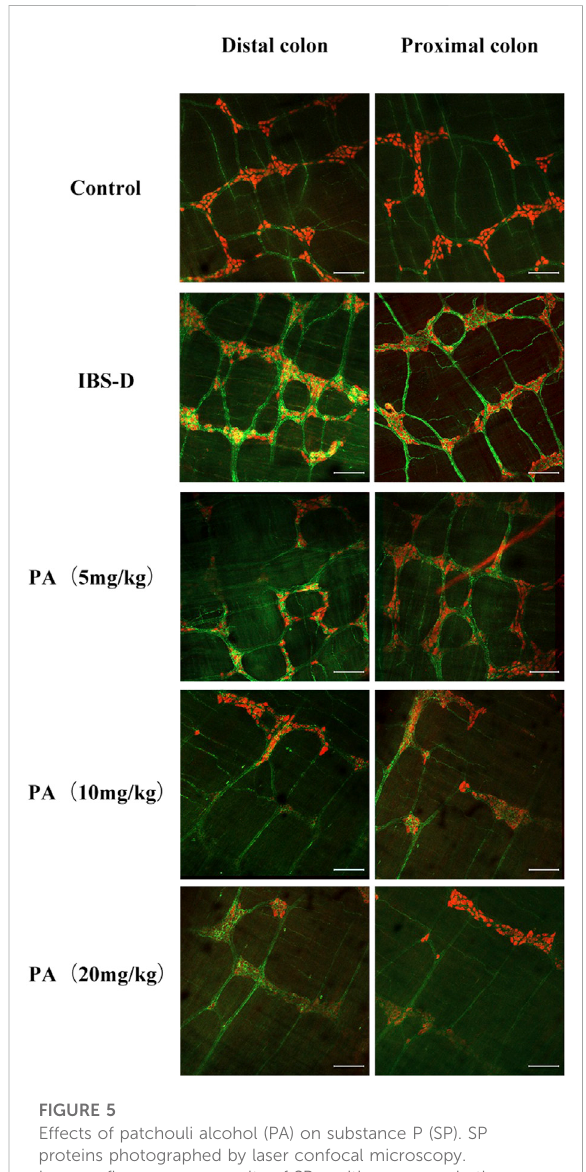
FIGURE 5 Effects of patchouli alcohol (PA) on substance P (SP). SP proteins photographed by laser confocal microscopy. Immuno fl uorescence results of SP positive neurons in the proximal and distal colon of PA groups. HuC/D (Red), SP(Green). Scale Bar = 100 μ